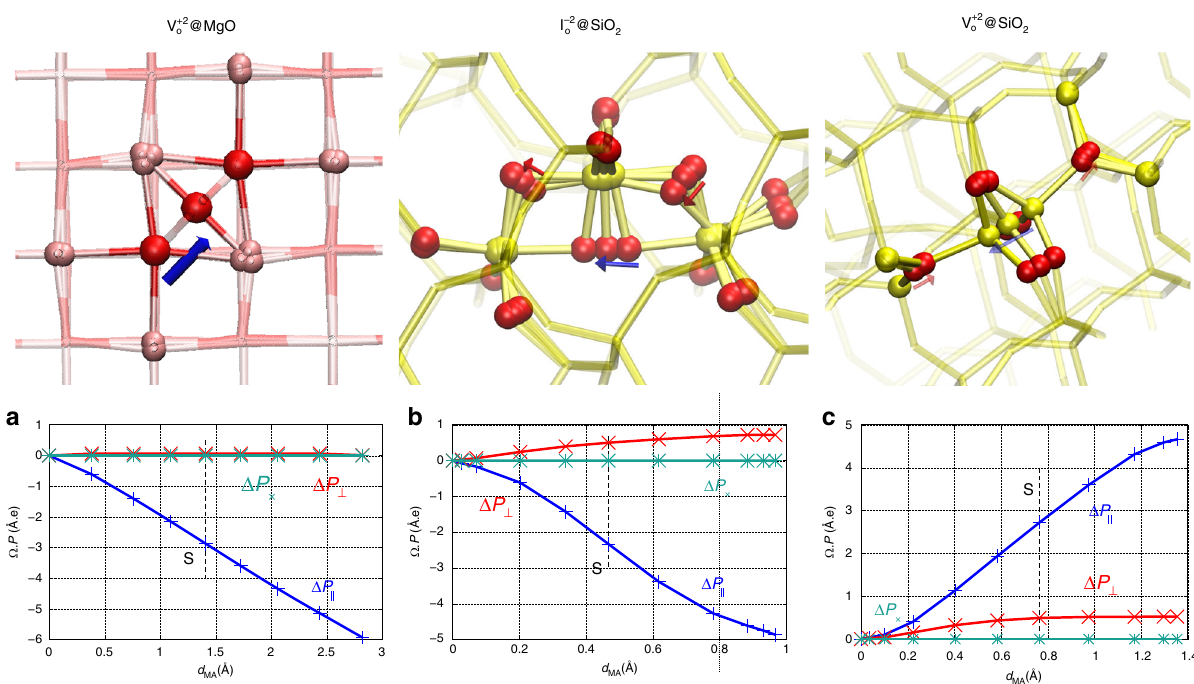
Fig. 1 Defect migration path and the corresponding macroscopic polarization change from fi rst principles. The top panels describe the atomic mechanism of the migration of a charged + 2 oxygen vacancy, V 2 þ V 2 þ , in SiO 2 . The remaining panels show the parallel ( Δ P ∥ ) and perpendicular projections ( Δ P ⊥ , Δ P × ) of Δ P as a function of the net displacement of the O migrating atom, d MA , along the reaction path, for, respectively, V 2 þ projection along the MA displacement vector ( d r the projections are de fi ned can be found in Supplementary Note 2.